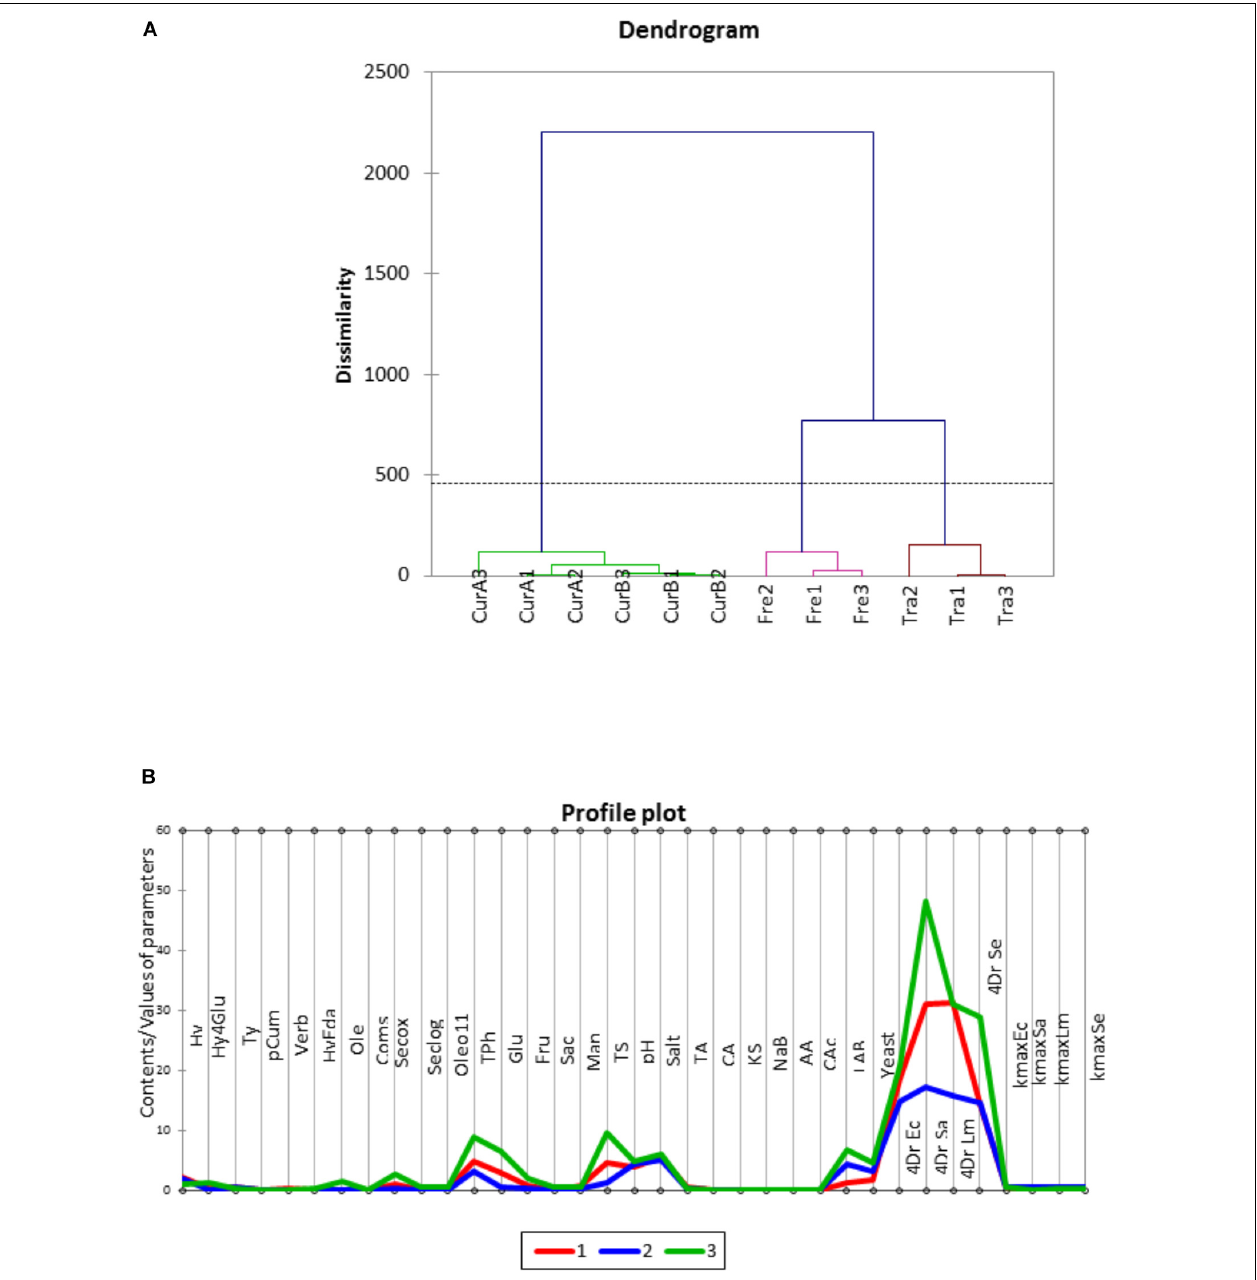
FIGURE 3 | Cluster analysis of treatments, and their replicates, based on polyphenols, sugars, pH, salt, organic acids, preservatives, and fit parameters (A) , and their profiles (B) . Trad, traditional Aloreña de Málaga presentation; Fresh, fresh green presentation; CUR-A and CUR-B refer to the two industries which elaborated the cured presentations. Lines 1, 2 and 3 represents the grouped clusters. See Table 1 for the rest of